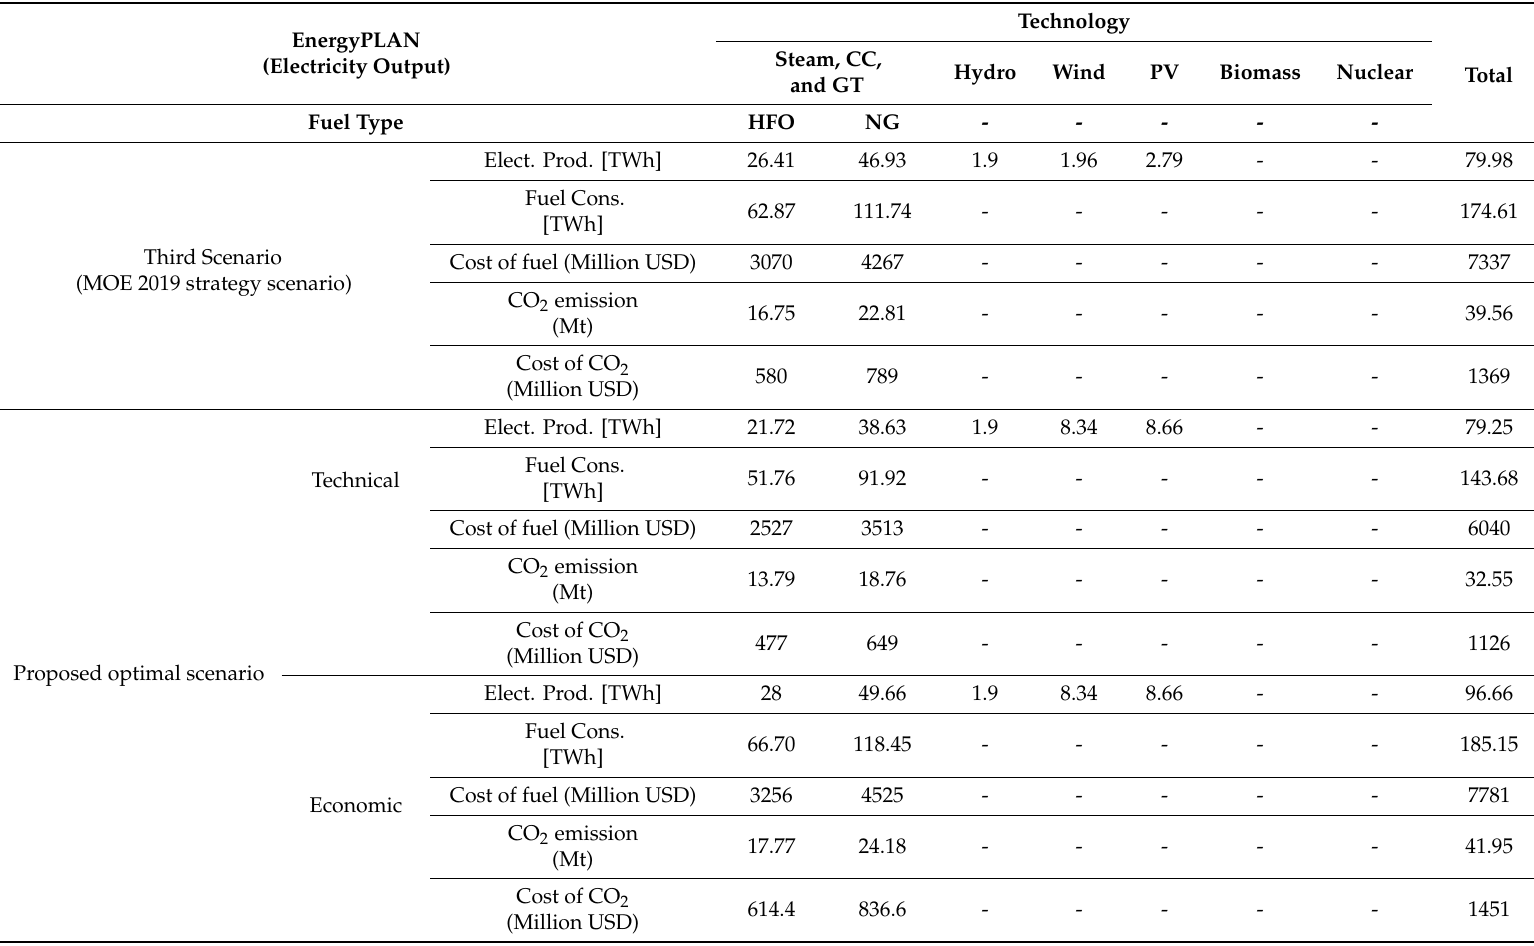
Table 15. Electricity production, fuel consumption, cost of fuel, CO 2 emission, and cost of CO 2 for the first and proposed